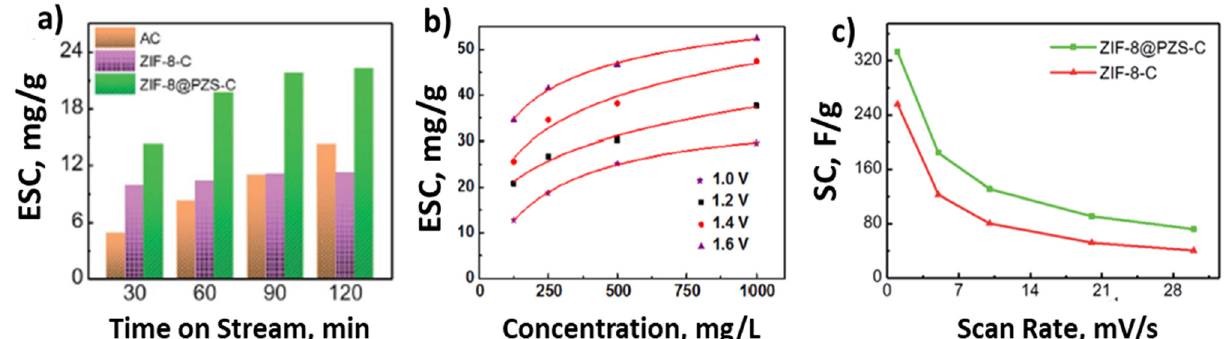
Figure 15. ( a ) Plot of SC vs. deionization time of stream of various electrodes in a 500 mg/L NaCl solution with flow rates of 50 mL/min. ( b ) The electrosorption isotherms of PC/rGO-20 electrode as a function of cell potentials and NaCl concentration. ( c ) Specific capacitance of ZIF-8-C and ZIF-8@PZS-C at different scan rates. Adapted from [49,137]. Table 4. Summary of properties of MOF-based CDI electrodes for desalination. Adapted from Han et al. [46]. Electrode